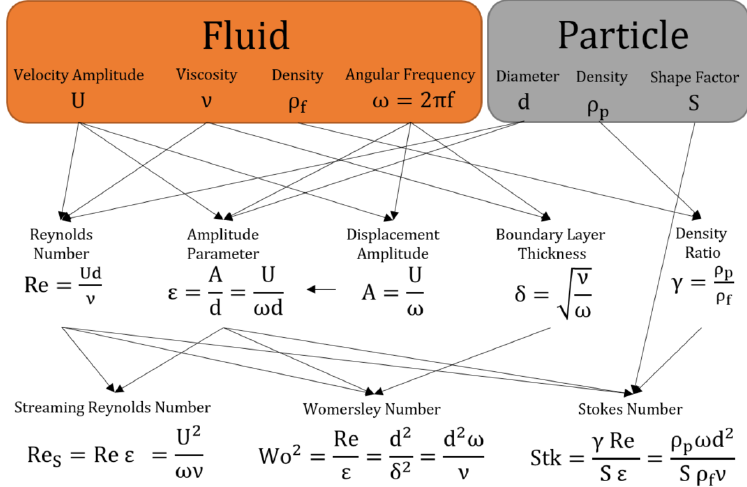
Figure A1. Derivation and relations of central dimensionless